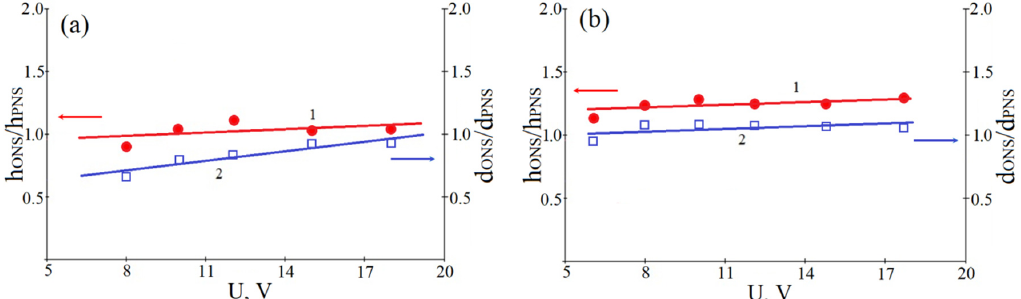
Figure 6. Dependence of the ratio of the height (diameter) of the ONS and the depth (diameter) of the PNS on the voltage amplitude of the LAO at di ff erent humidity: ( a )—70 ± 1%; ( b )—90 ± 1%. (1—ratio of ONS height and PNS depth; 2—ratio of ONS and PNS diameters).